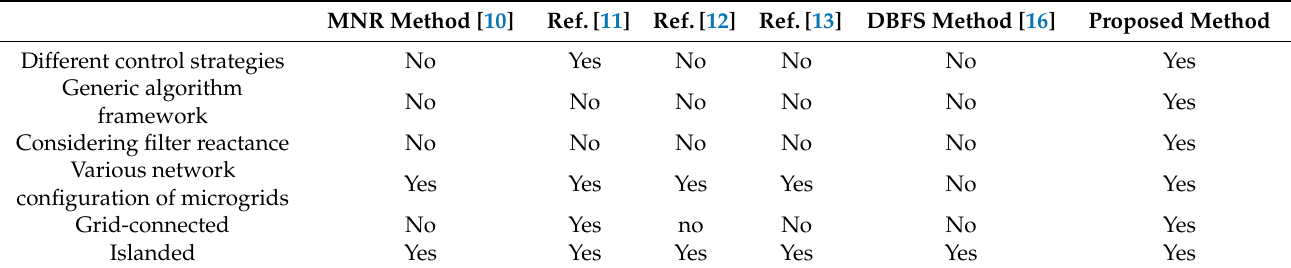
Table 2. Comparison between power flow